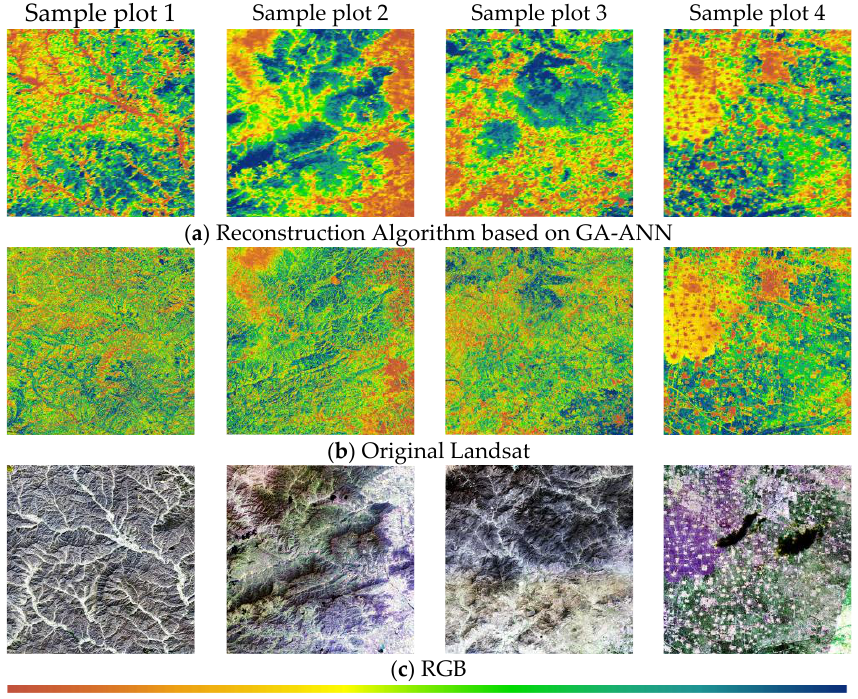
Figure 5. Authenticity test between reconstructed NDVI model and original Landsat NDVI.